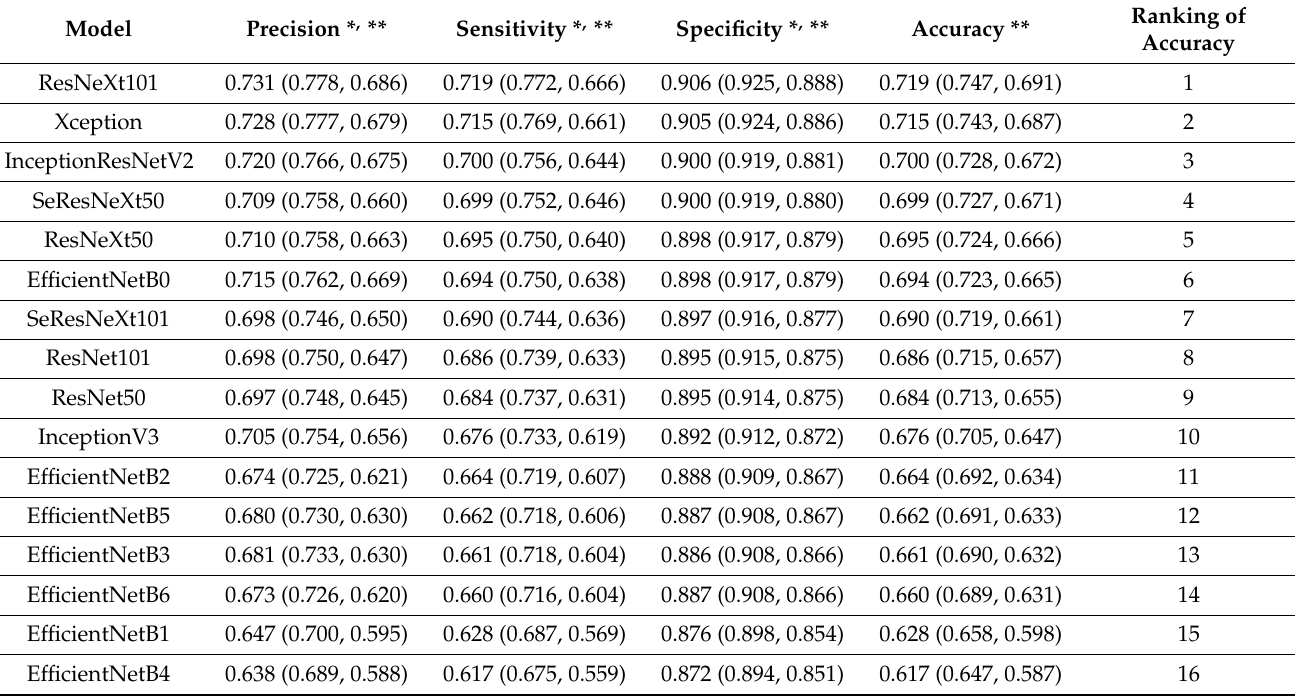
Table 4. The evaluation metrics for each of the 16